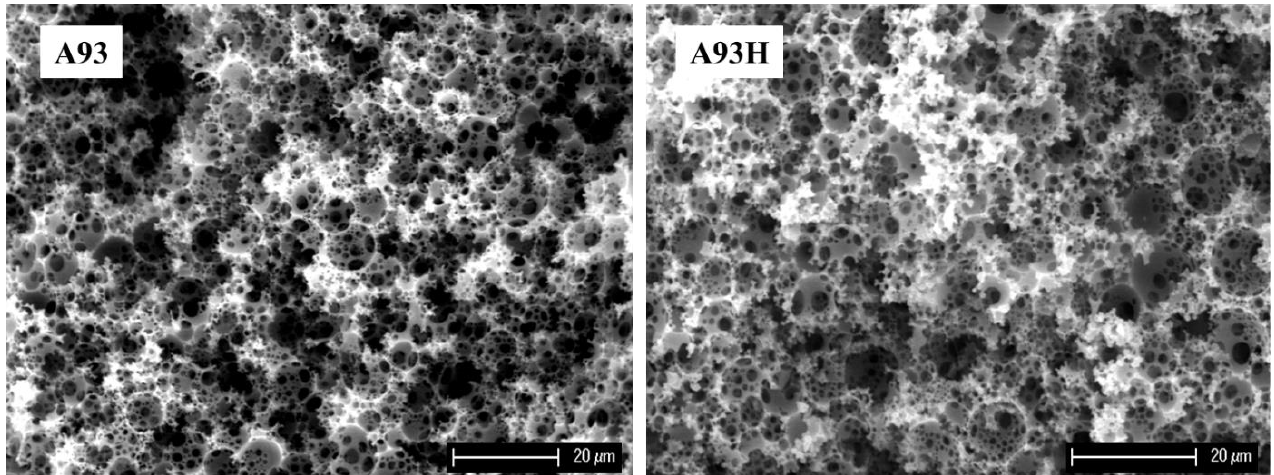
Figure 2. Scanning electron micrographs of polyHIPE samples A93 and A93H . Substantially higher BET surface of the hypercrosslinked polymers indicates the formation of new porosity. However, hypercrosslinking is known to produce microporosity with pores smaller than 2 nm [47]. Such narrow pores are filled with the sorbate sooner than the BET equation-described multilayer adsorption begins. Standard evaluation of the BET surface of such materials interprets the sorbate amount filling the micropores as a part of the BET multilayer, which produces incorrect BET surface area data. It is possible to distinguish between micropore volume and external surface area using the t -plot method, which is plotting the adsorbed amount against thickness of the adsorbed layer